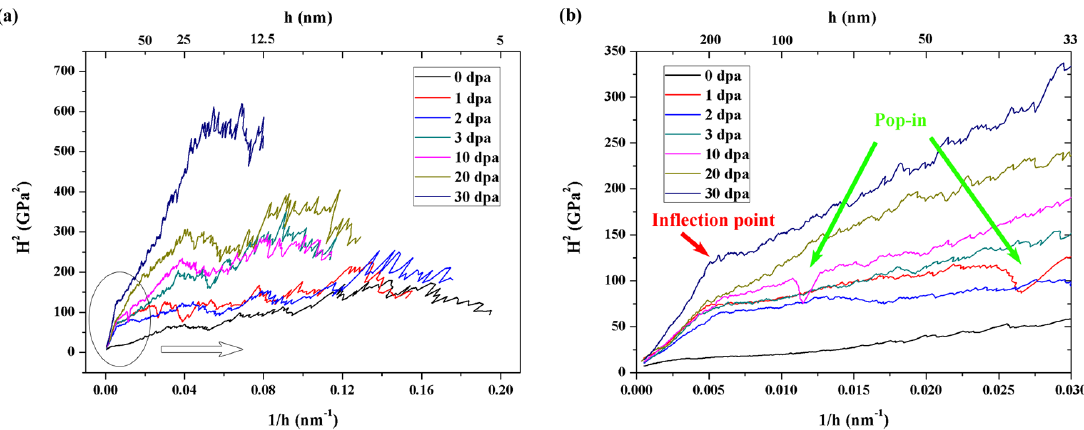
Figure 5. H 2 versus 1/ h profile for the indentation size effect (ISE) region according to the Nix-Gao model, the circled area in ( a ) is enlarged in ( b ).